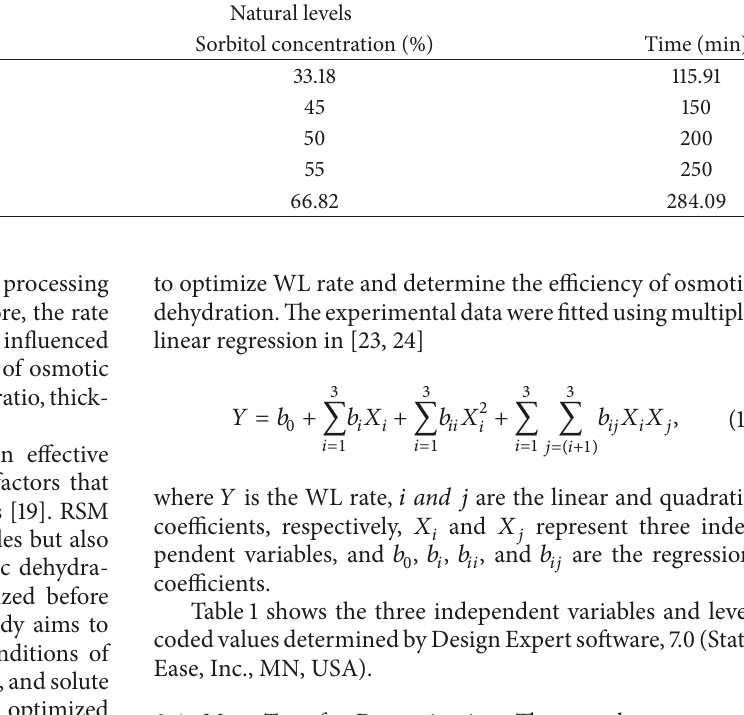
Table 1: Independent variables and their levels used in the central composite rotatable design for strawberry osmotic dehydration. Coded